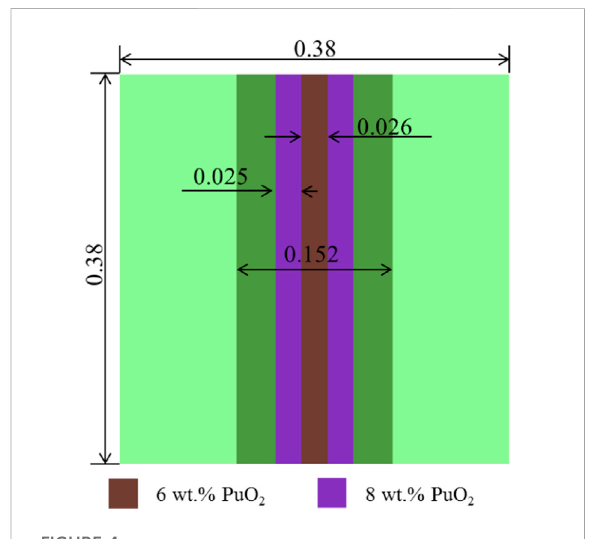
FIGURE 4 The geometry of the plate cell with non-uniform material composition, unit in cm.